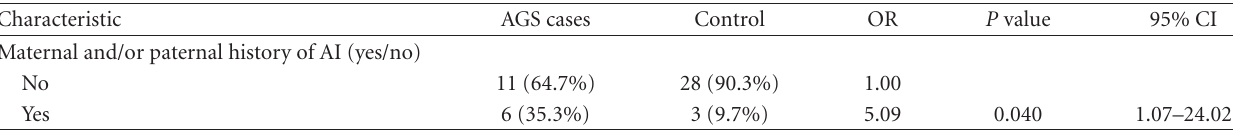
Table 3: Comparison of autoimmune disease reported in first degree relatives in US-based cohort